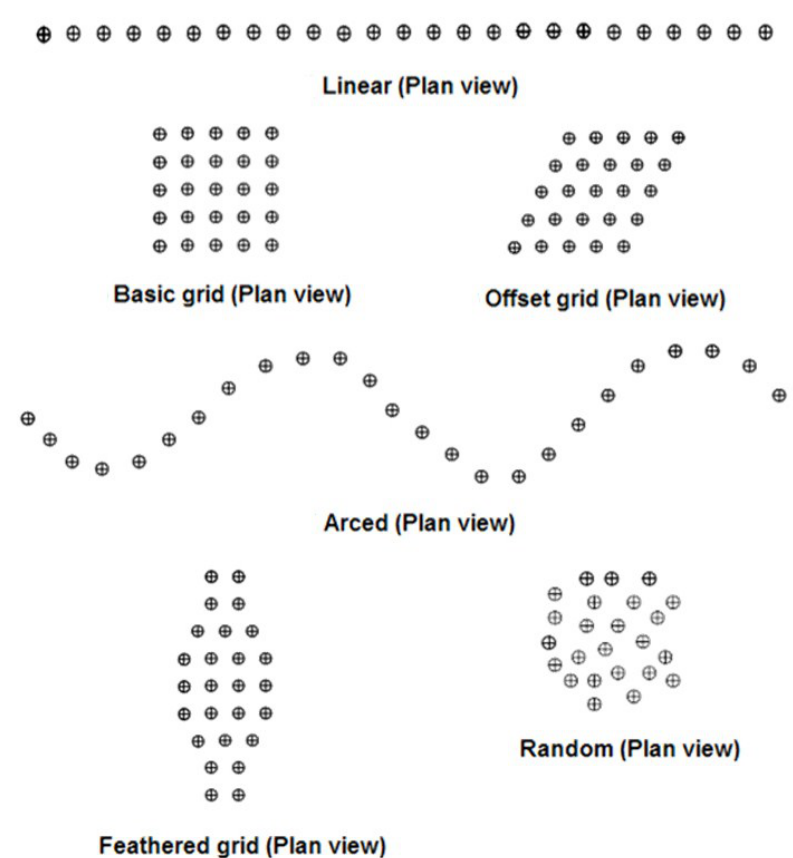
Figure 1. Various wind farm layout